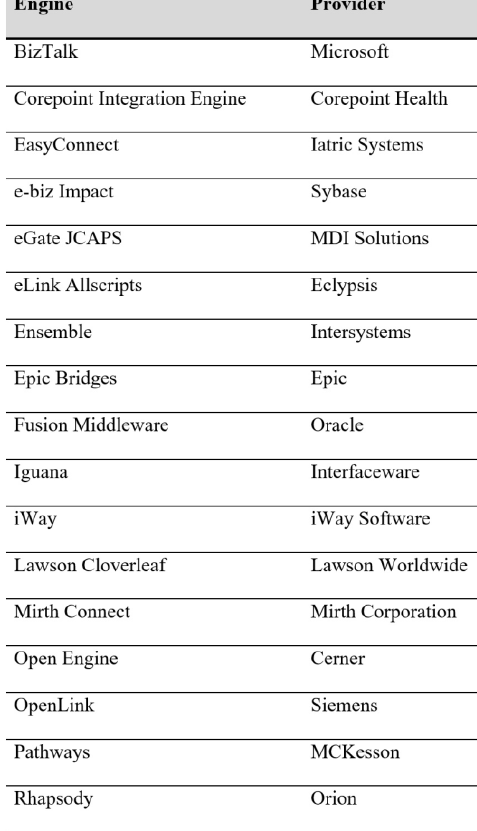
Figure 8. Main alternatives of integration